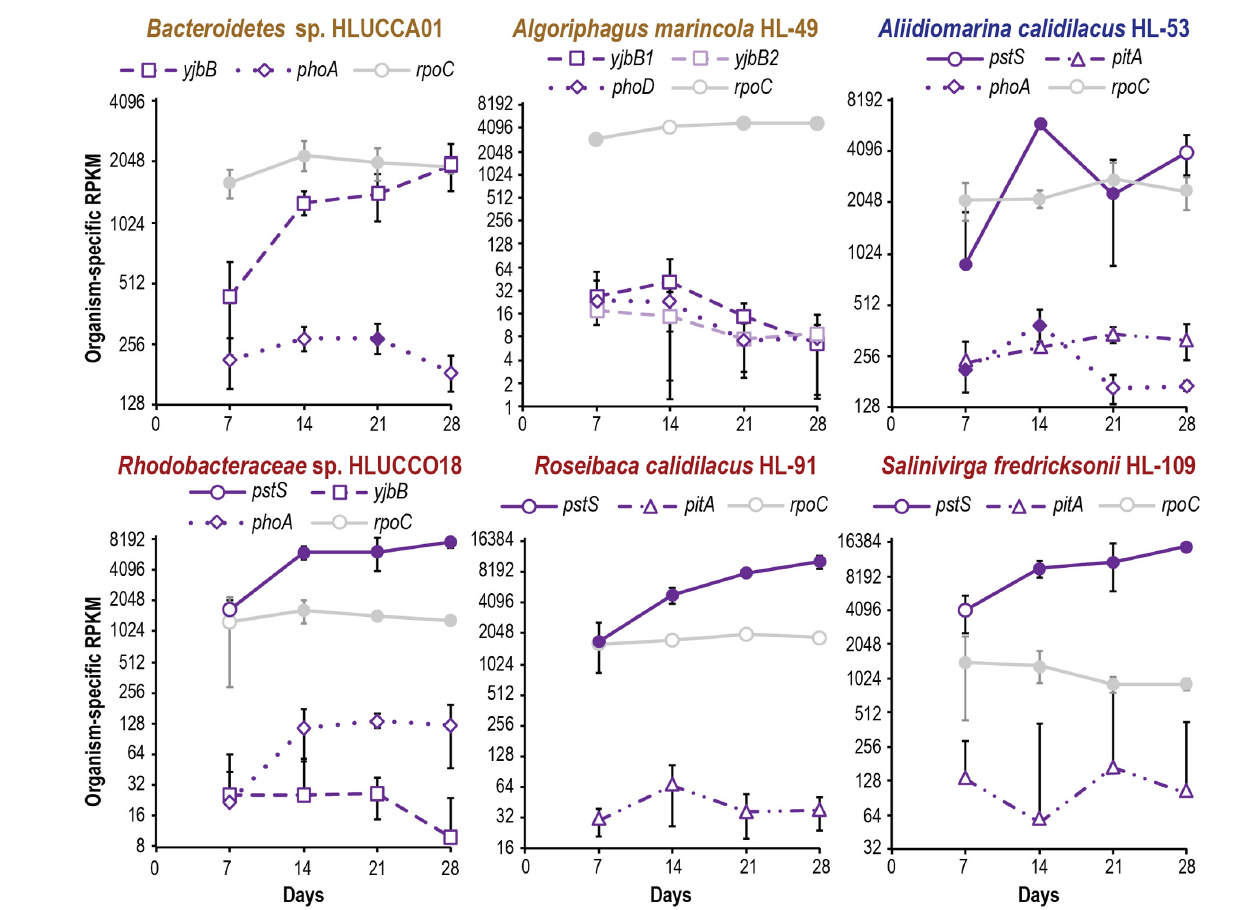
FIGURE 4 | Metatranscriptomic evaluation of phosphate acquisition gene expression in major heterotrophic species during succession. Expression of the substrate-binding subunit pstS is plotted as an indicative gene for pstSABC , as other transporters and phosphates are each encoded by a single gene. In organisms where they are present, the pst genes are operonic and expression of pstABC displayed similar trends as pstS ( Supplementary Table S4 ). Organism-specific RPKM is plotted on a log 2 scale; error bars indicate 95% confidence interval of the mean (where the 95% confidence interval is inclusive of zero or below, negative error bars are not shown). Filled symbols indicate that two or more peptides were observed for a gene’s product at a given time point; open symbols denote no or inadequate proteomic evidence. Expression of rpoC is included as a